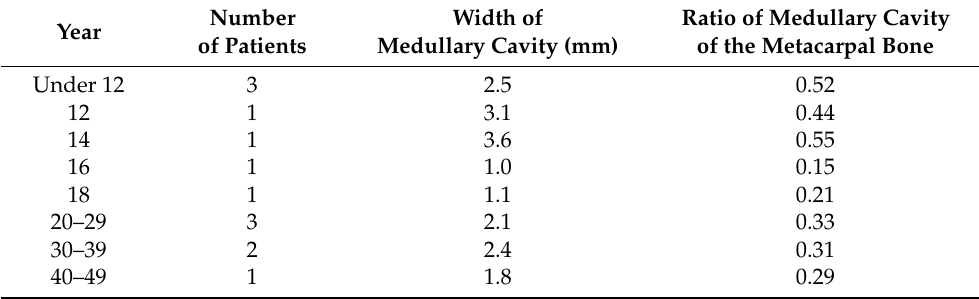
Table 5. Mean width of the medullary cavity of the third metacarpal and ratio of medullary cavity of the metacarpal